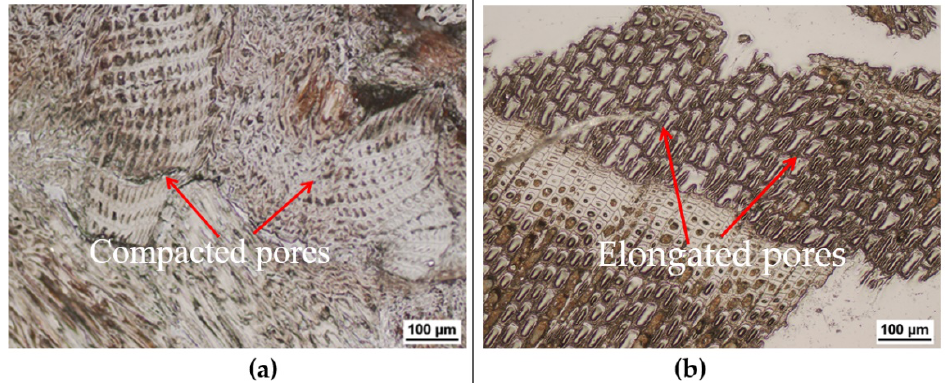
Figure 1. Microstructure images of ( a ) TSDa and ( b ) TSD. Red arrows indicate compacted and elongated pores in ( a ) and ( b ), respectively.